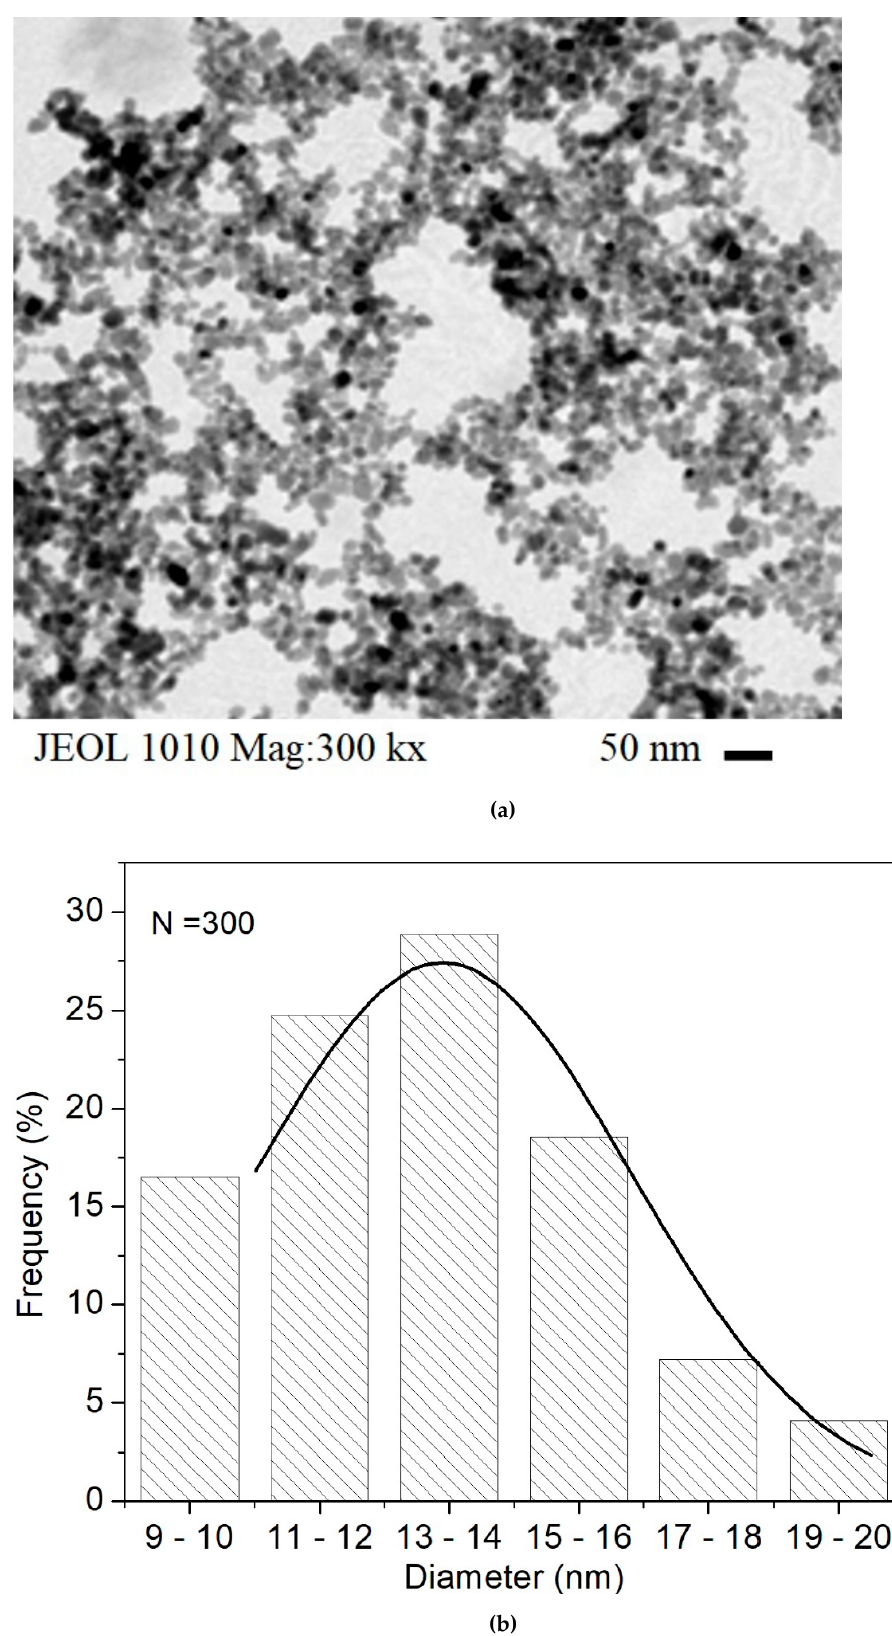
Figure 2. ( a ) A typical TEM micrograph (300 kx) of coated MNPs and ( b ) the corresponding bars plot and Gaussian fit.